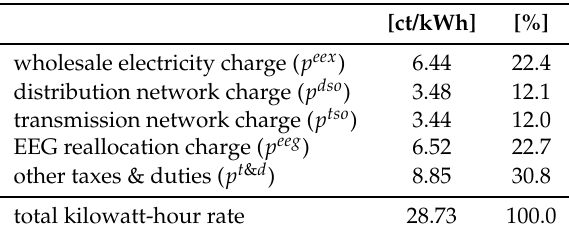
Table 2. Components of end-user electricity price.